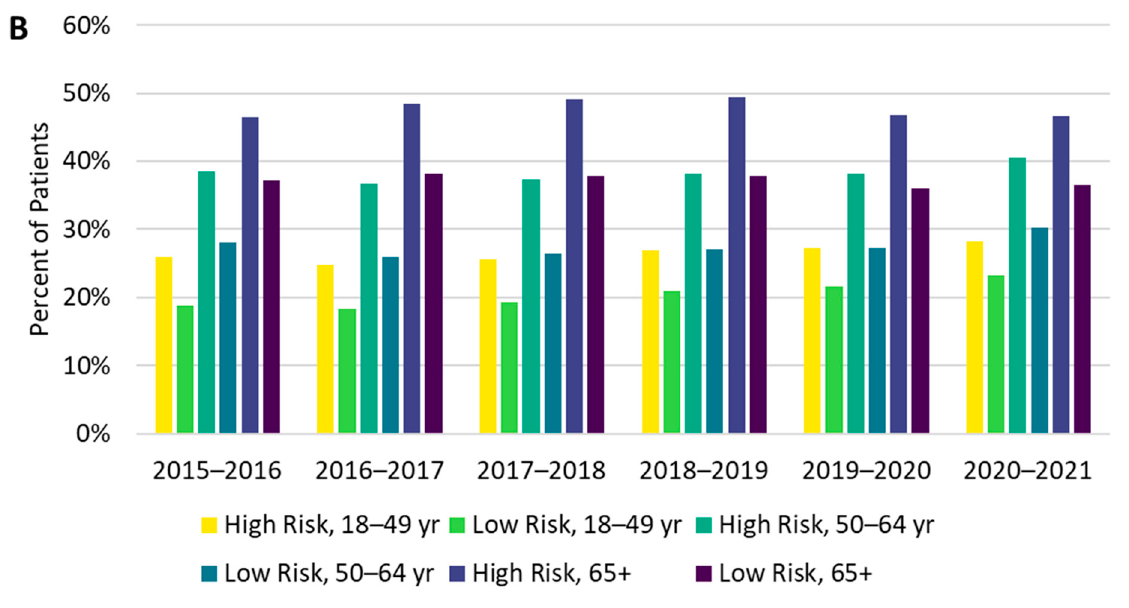
Figure 3. Vaccine uptake from the 2015–2016 through the 2020–2021 influenza seasons by risk and age group for individuals ( A ) 1–17 years of age and ( B ) 18 years and